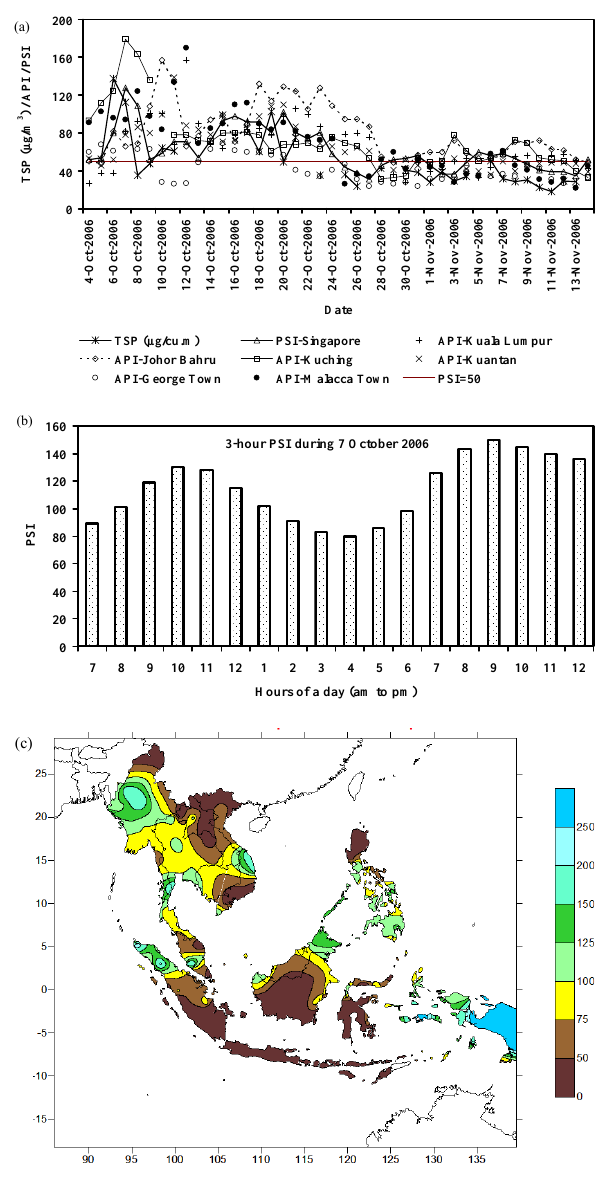
Fig. 3. (a) 3-hr PSI on 7 October 2006; (b) Total Suspended Particulates (TSP), Pollutant Standards Index (PSI) (Data from NEA, Singapore) 836 Fig. 3. (a) 3-h PSI on 7 October 2006; (b) Total Suspended Particu- and Air pollution index (API) (Data from DOE, Malaysia) from October 2006 to November 2006; (c) Percentage of normal rainfall distribution 837 in SEA during September 2006 (NEA, Singapore). Note: PSI or API < 50 (Good); 51-100 (Moderate); 101-200 (Unhealthy); 201-300 (Very 838 lates (TSP), Pollutant Standards Index (PSI) (Data from NEA, Sin- Unhealthy); > 300 (Hazardous). 839 gapore) and Air pollution index (API) (Data from DOE,